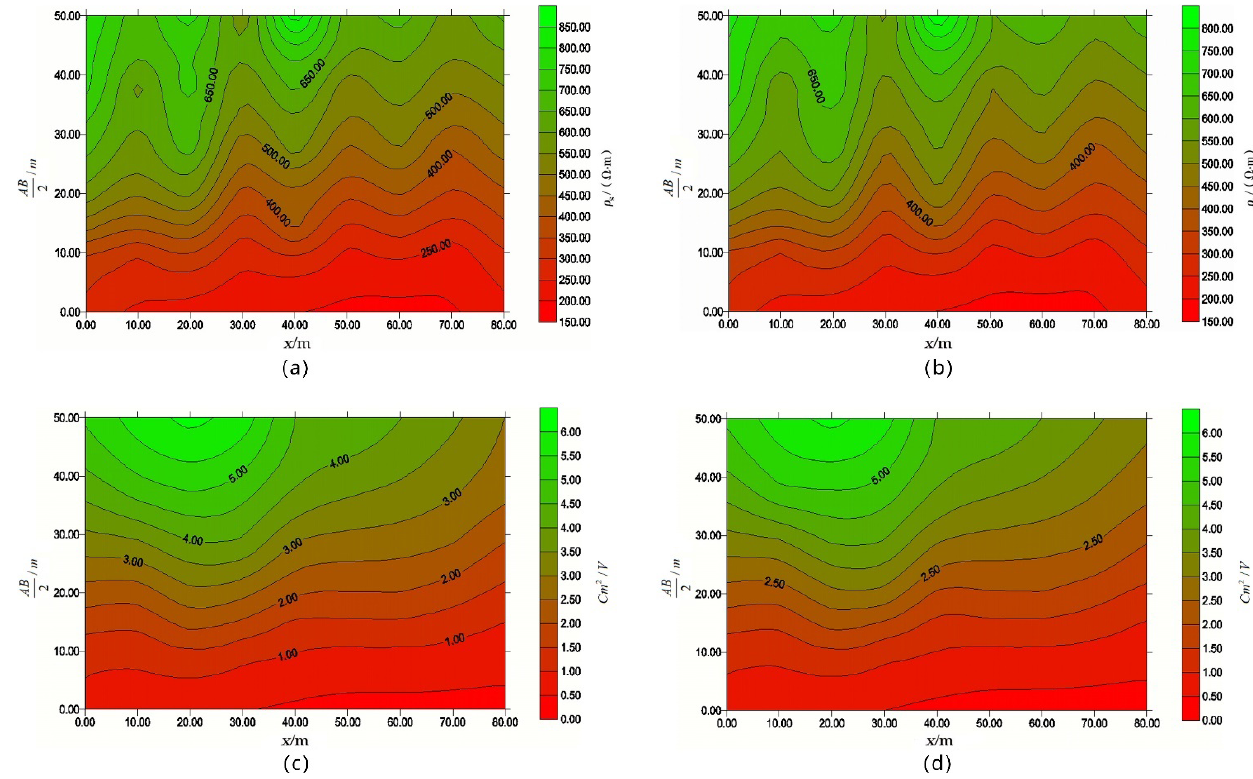
Figure 9. Pseudo-sections of field comparative experiment. (a) Pseudo-section of apparent resistivity by DUK-2A. (b) Pseudo-section of apparent resistivity by CUGB-CS48DAS. (c) Pseudo-section of apparent polarizability by DUK-2A. (d) Pseudo-section of apparent polariz- ability by CUGB-CS48DAS.